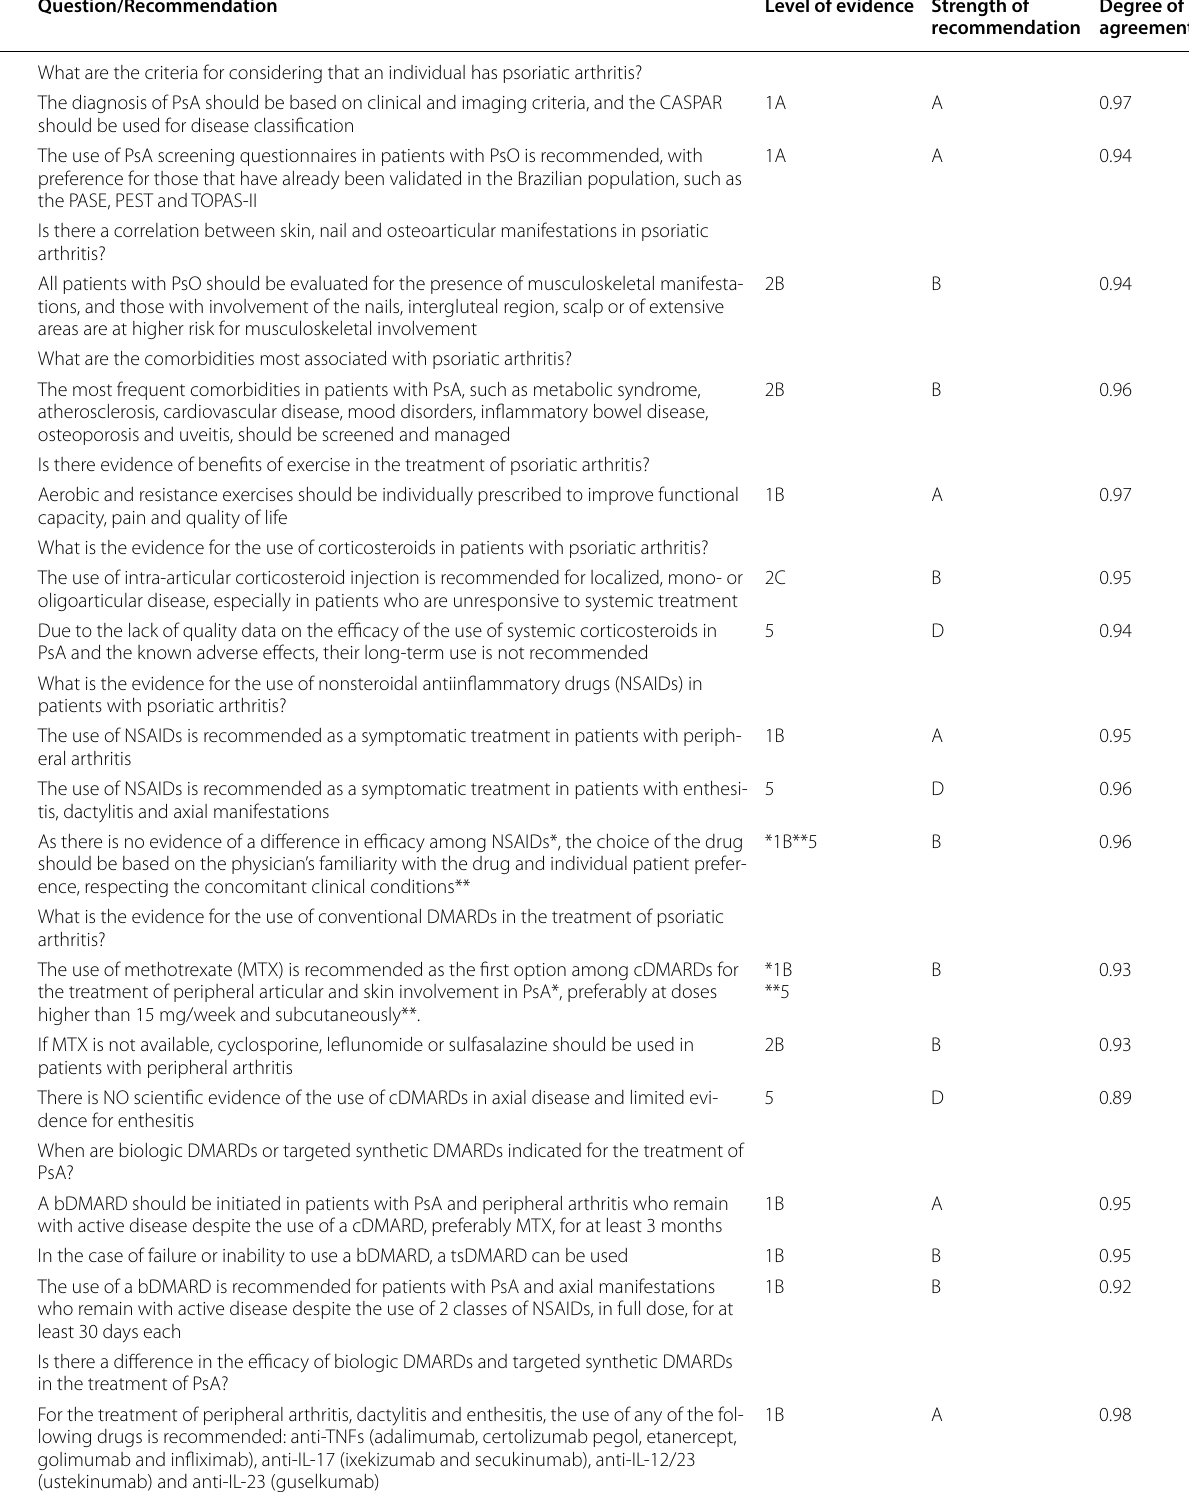
Table 6 Guidelines of the Brazilian Society of Rheumatology for the diagnosis and treatment of psoriatic arthritis with their respective level of evidence, strength of recommendation and degree of agreement among experts (interrater reliability), 2020 Question/Recommendation Level of evidence Strength of